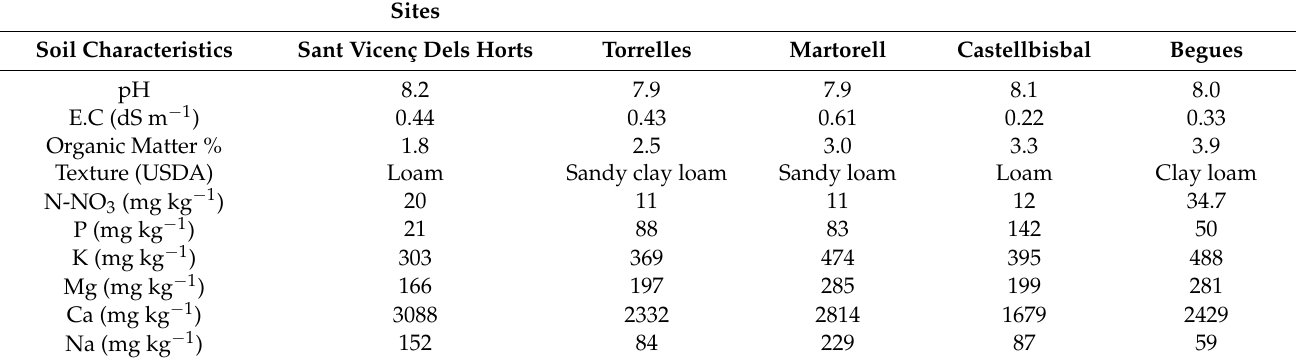
Table 1. Physicochemical soil characteristics of the organic vegetable production sites.